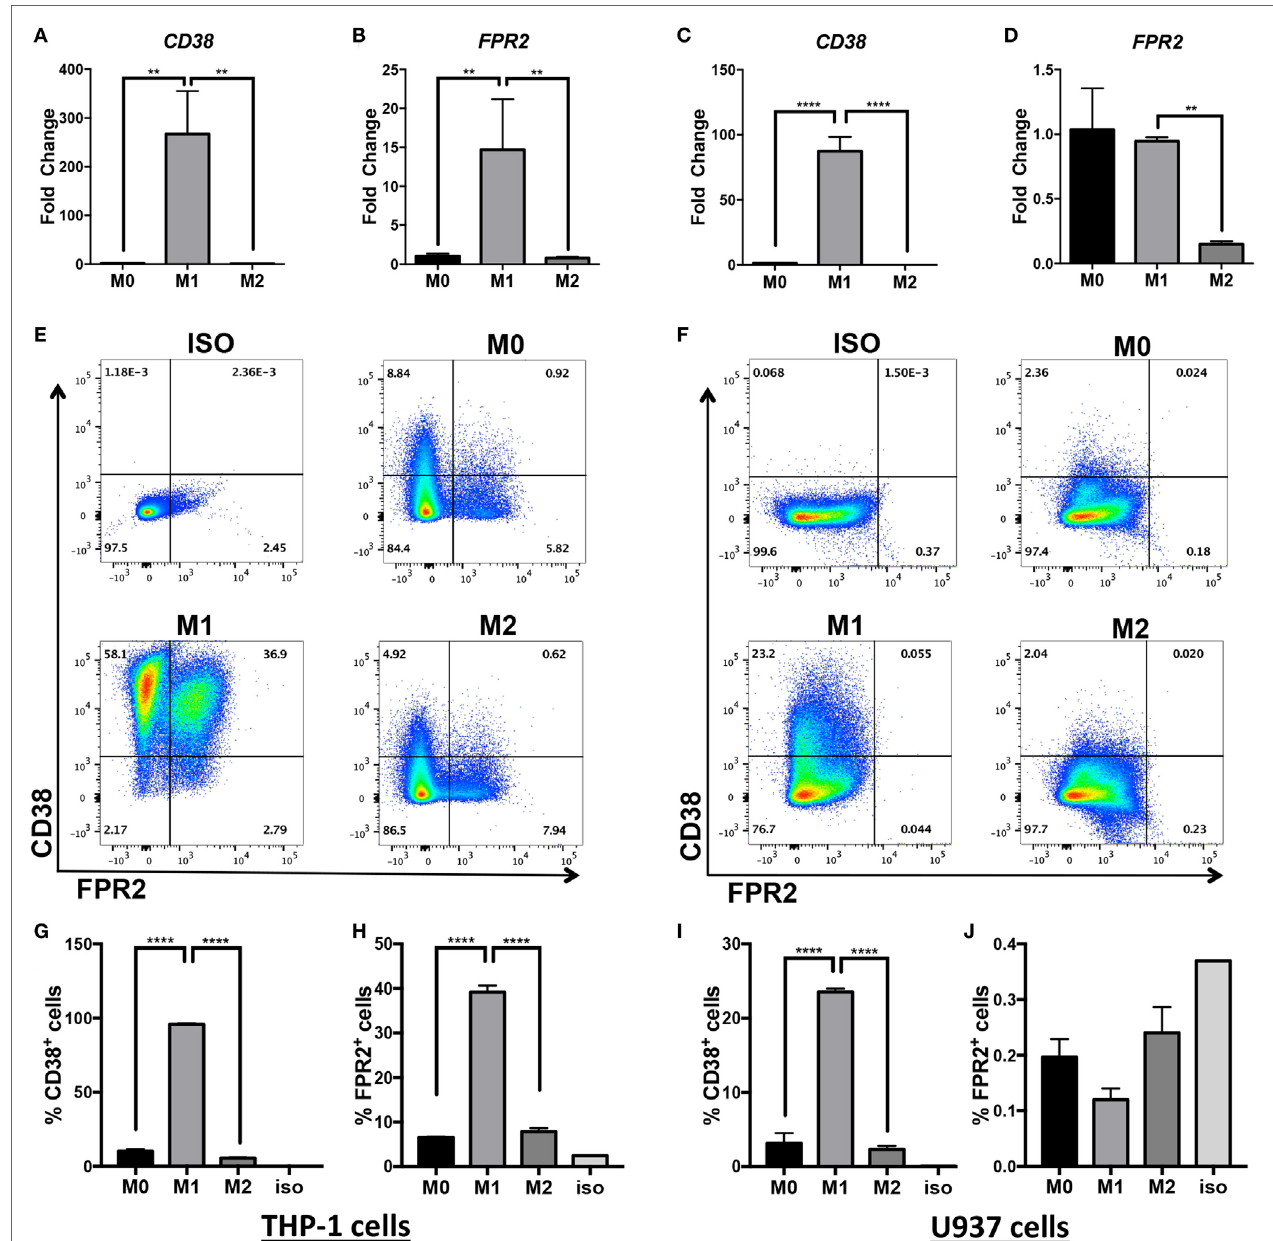
FigUre 1 | CD38 mRNA and protein expression is increased in human monocytic cell lines differentiated into M(LPS + IFN- γ ) macrophages. Expression of CD38 and FPR2 mRNA in THP-1 (a,B) and U937-derived macrophages (c,D) in unstimulated (M0), M(LPS + IFN- γ )-stimulated (labeled M1 throughout figure), or M(IL-4)-stimulated (labeled M2 throughout figure) macrophages was measured by real-time PCR and expressed as mean relative expression ± SD ( n = 3 biological replicates with two technical replicates per sample). Gene expression is expressed as fold change ± SD relative to M0 condition. One-way analysis of variance with p values adjusted for multiple comparisons using Sidak’s multiple comparisons test compare M(LPS + IFN- γ ) vs . M0 and M(LPS + IFN- γ ) vs . M(IL-4). (e,F) Flow cytometry staining of surface FPR2 on x -axis, CD38 on y -axis in THP-1 (e) and U937 (F) cells. Flow plots correspond to total cells. Data shown are representative of n = 3 biological replicates. (g–J) Quantification of CD38 + cells and FPR2 + cells in THP-1 (g,h) or U937 cells (i,J) are expressed as percent of positive cells ± SD ( n = 3 biological replicates); ISO, isotype control; ** p < 0.01, **** p <